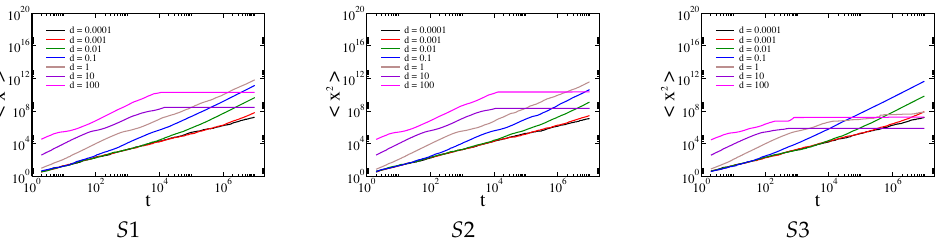
Figure 9. Dependence of the average of the square displacement x 2 on time driven by Gaussian random walk in the structures S1, S2, and S3, respectively. The effective diffusion exponent for both types of transport is shown in Figure 10.